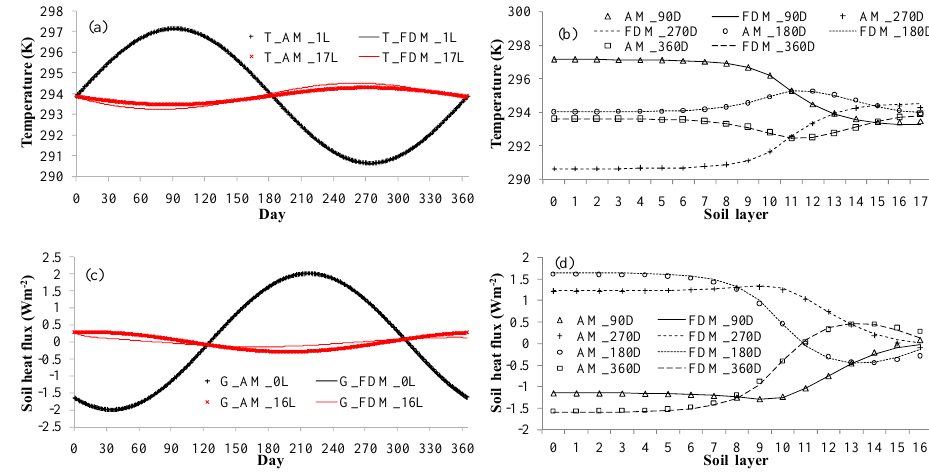
Figure 4. The comparison of daily soil temperature ( T , a and b ) and soil heat flux ( G , c and d ) between analytical method (AM) and finite difference method (FDM) for soil heat conduction–convection model by using 8M17L discretization with liquid water flux q L = 1 × 10 − 7 ms − 1 (8.6mmd − 1 ): time serials (a , c) and vertical profiles (b , d) . The black lines and red lines in (a) plot the values at the first layer (1L) and at the 17th layer (17L), respectively. The black lines and red lines in (c) plot the values at the surface (0L) and at the 16th layer (16L), respectively. The symbols (cid:52) , + , (cid:13) , (cid:3) in (b) and (d) correspond to AM values at 90th day (90D), 270th day (270D), 180th day (180D), and 360th day (360D), respectively. The different lines “——”, “– – – – –”, “- - - - - - - - -”, and “— — — —” in (b) and (d) correspond to FDM values at 90D, 270D, 180D, and 360D, respectively.